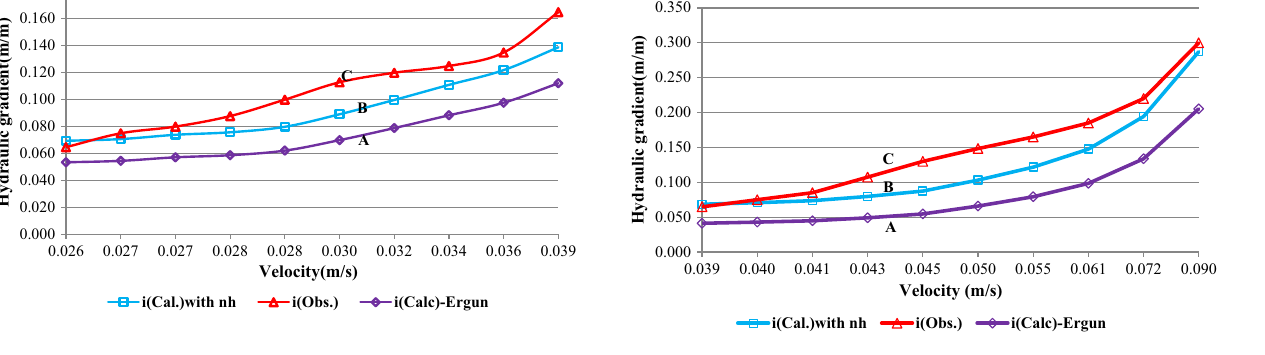
Fig. 11 Comparing plots of hydraulic gradient versus velocity for CGM2 series. Results are start of run. Curve “A” shows variations of ( i ) versus ( V ) based on common porosity concept. Curve “B” shows variations of ( i ) versus ( V ) based on hydraulic porosity concept. Curve “C” shows variations of ( i ) versus ( V ) based on actual model